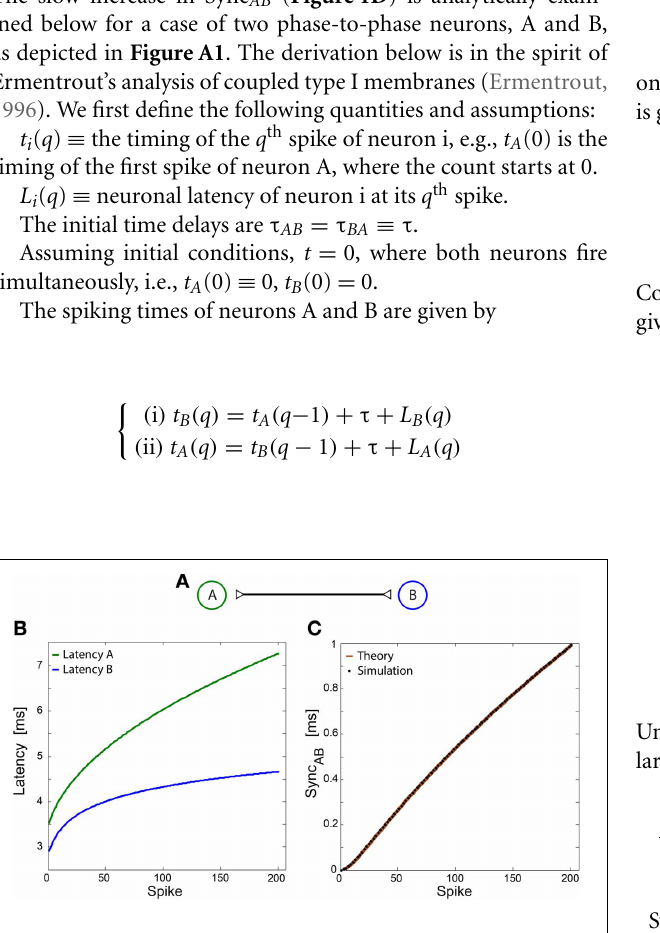
FIGURE A1 | Slow divergence out of synchrony between two phase-to-phase neurons. Notation used: Sync AB , the time-lag between the spikes of neurons A and B. (A) Schematic of two bidirectional interconnected spiking neurons. The initial delays between the neurons are equal, τ AB = τ BA = τ . (B) Response latency of both neurons as a function of spike number. The latencies were taken to be L A = 0 . 5 × ln( q + 5) + 2, L B = 0 . 3 × sqrt( q + 2) + 3, qualitatively similar to latency profiles observed in experiments. (C) Sync AB as a function of spike number for the latencies depicted in (B) , assuming Sync AB (0) = 0. The calculation (brown line) was done using Equation (A1) and is in a good agreement with straightforward simulations of exact spike times (black dots). For simplicity, the simulated Sync AB is only displayed for even numbers of